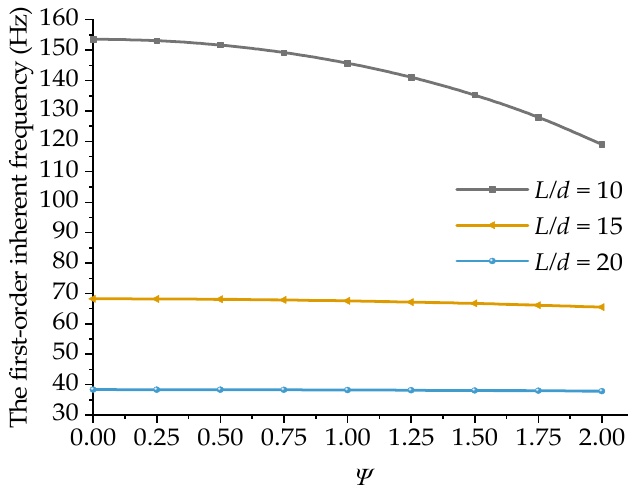
Figure 6. Variations in the first-order inherent frequency with the damping ratio of the boring bar under different length-to-diameter ratios ( TR = 0 and ψ = 0 ).